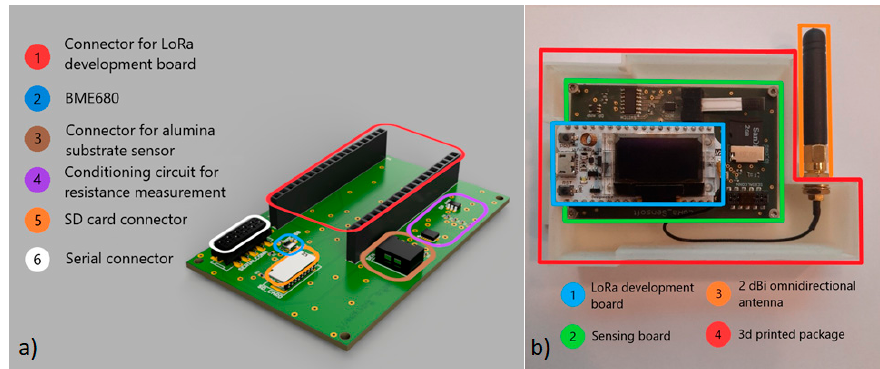
Figure 2. ( a ) Sensing board built for LoRa (short for long-range) nodes development and ( b ) end node without the front cover.